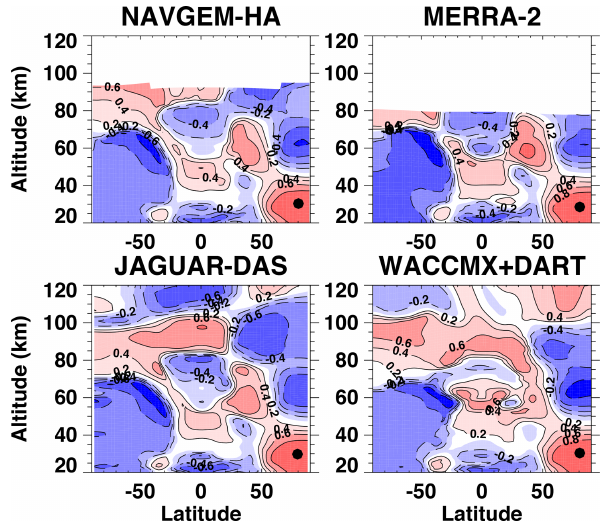
Figure 9. Latitude–altitude cross-sections of the correlation coef- ficient between daily zonal mean temperature at 30km and 80 ◦ N (indicated by the black-filled symbol) and daily zonal mean tem- perature at all other latitudes and altitudes in NAVGEM-HA, MERRA-2, JAGUAR-DAS, and WACCMX + DART. Correlation values equal 1 at the location of the black-filled symbols at 30km and 80 ◦ N. Negative (positive) values are contoured every 0.2 using dashed (solid) black lines. The SSW disturbance time period over which the correlation coefficient is calculated is from 27 January to 9